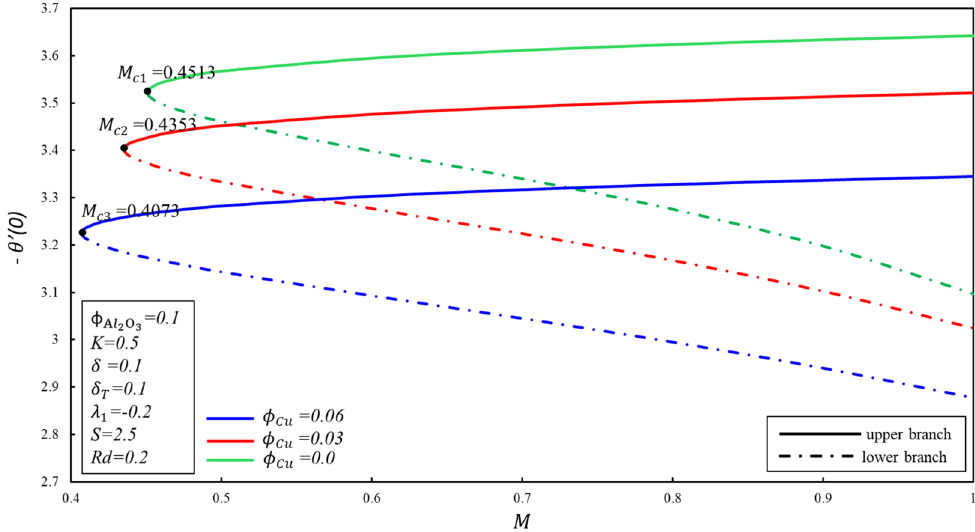
θ ′ ( 0 ) in impact of φ Cu . −